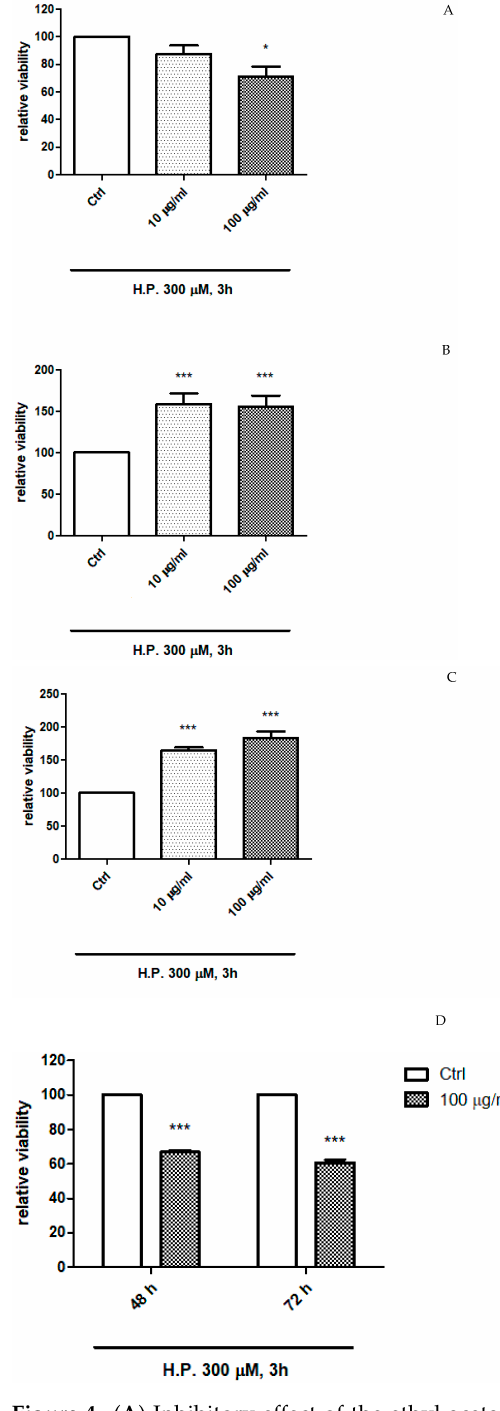
Figure 4. ( A ) Inhibitory effect of the ethyl acetate extract 10–100 µg/mL from the aerial parts of Pelargonium quercetorum on the viability of human colon cancer HCT116 cells exposed to hydrogen peroxide (H.P.) 300 µM. * p < 0.05 vs. Ctrl group. ( B ) Stimulatory effect of the methanol extract 10–100 µg/mL from the aerial parts of Pelargonium quercetorum on the viability of human colon cancer HCT116 cells exposed to hydrogen peroxide (H.P.) 300 µM. *** p < 0.001 vs. Ctrl group. ( C ) Stimulatory effect of the water extract 10–100 µg/mL from the aerial parts of Pelargonium quercetorum on the viability of human colon cancer HCT116 cells exposed to hydrogen peroxide (H.P.) 300 µM. *** p < 0.001 vs. Ctrl group. ( D ) Inhibitory effect of the ethyl acetate extract 100 µg/mL from the aerial parts of Pelargonium quercetorum on the viability of human colon cancer HCT116 cells exposed to hydrogen peroxide (H.P.) 300 µM, after 48 and 72 h of exposure to the extract (*** p < 0.001).